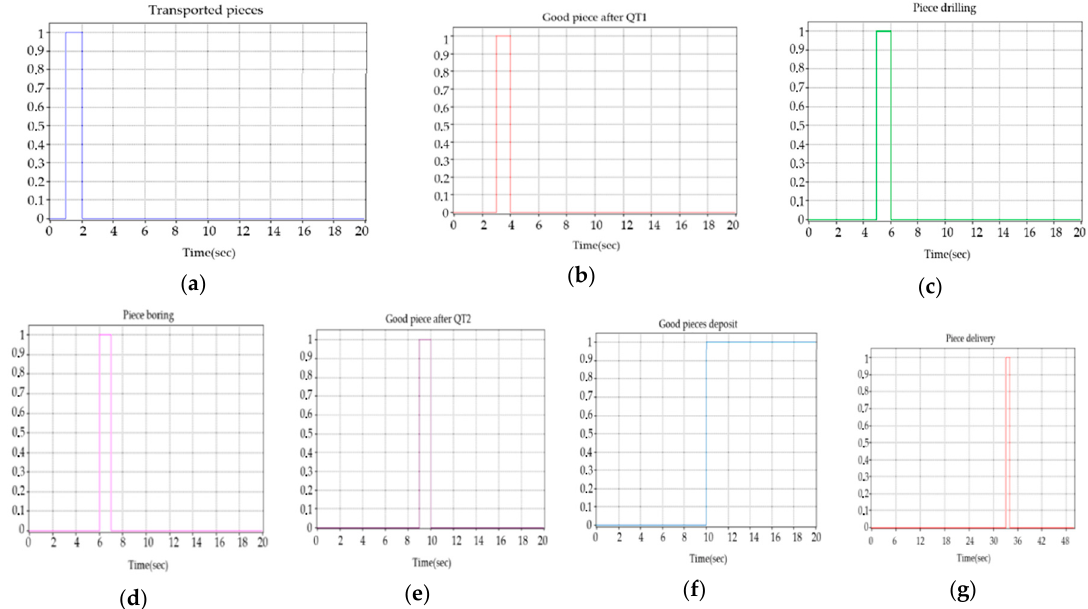
Figure 7. Discrete place evolution of the work-piece on the P/RML, after the transitions corresponding to the actions: ( a ) transport; ( b ) QT1; ( c ) Drilling; ( d ) Boring; ( e ) QT2; ( f ) Storage ( g ) Delivery.